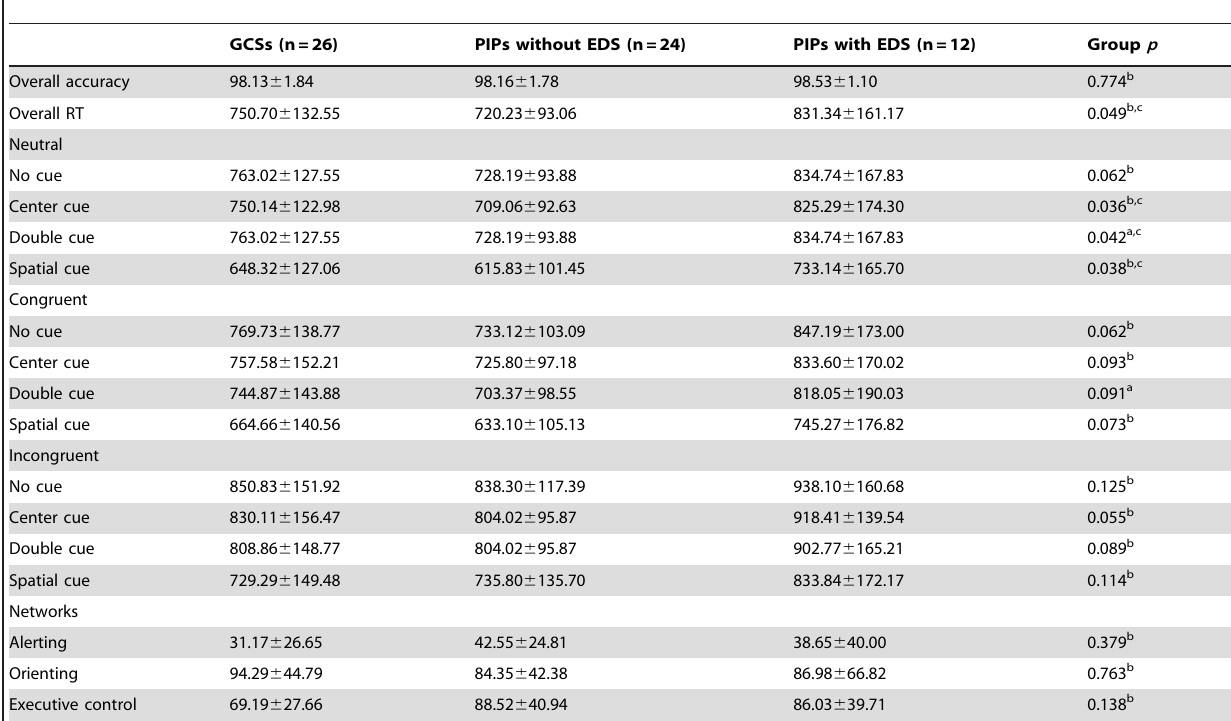
Table 3. ANT variables in GSCs, PIPs with EDS and PIPs without EDS (mean 6 SD).